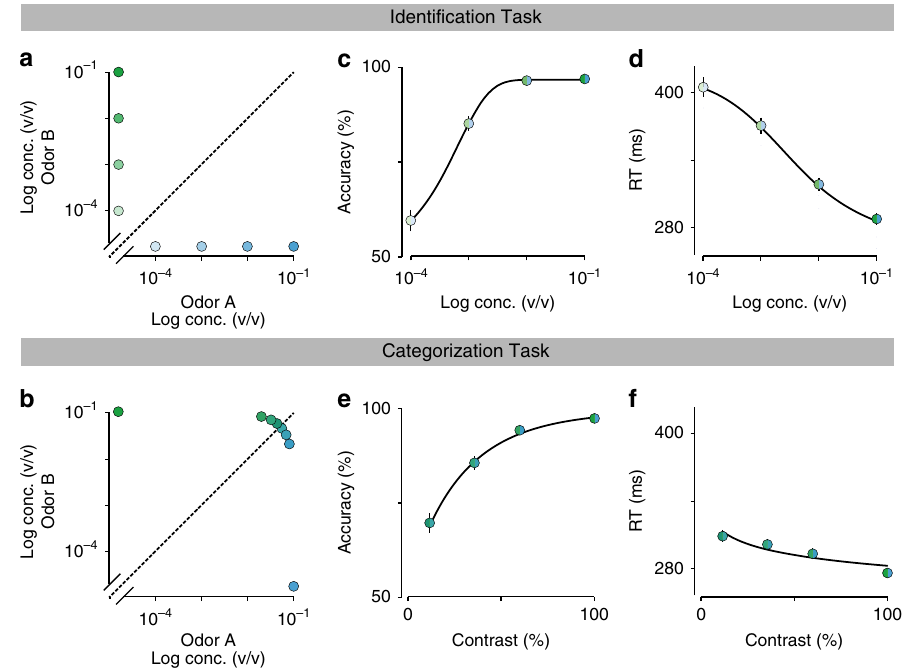
Fig. 2 Comparison between odor identi fi cation and mixture categorization tasks. a , b Stimulus design. In the odor identi fi cation task, the odorants were presented independently at concentrations ranging from 10 − 1 to 10 − 4 (v/v) and sides rewarded accordingly ( a ). For the mixture categorization task, the two odorants were mixed in different ratios presented at a fi xed total concentration of 10 − 1 , and rats were rewarded according to the majority component ( b ). Each dot represents one of the 8 stimuli presented for each task. c , d Mean accuracy ( c ) and mean reaction time ( d ) for the identi fi cation task plotted as a function of odor concentration. e , f Mean accuracy ( e ) and mean reaction time ( f ) for the categorization task plotted as a function of mixture contrast (i.e. the absolute percent difference between the two odors). Error bars are mean ± SEM over trials and rats. Colors in dots are presented as to help parse between stimulus space and psych- and chronometric curves. Solid lines depict the obtained fi ts for the predicted curves of a DDM, an exponential curve for performance and a hyperbolic tangent for RTs, as described in ref. 2